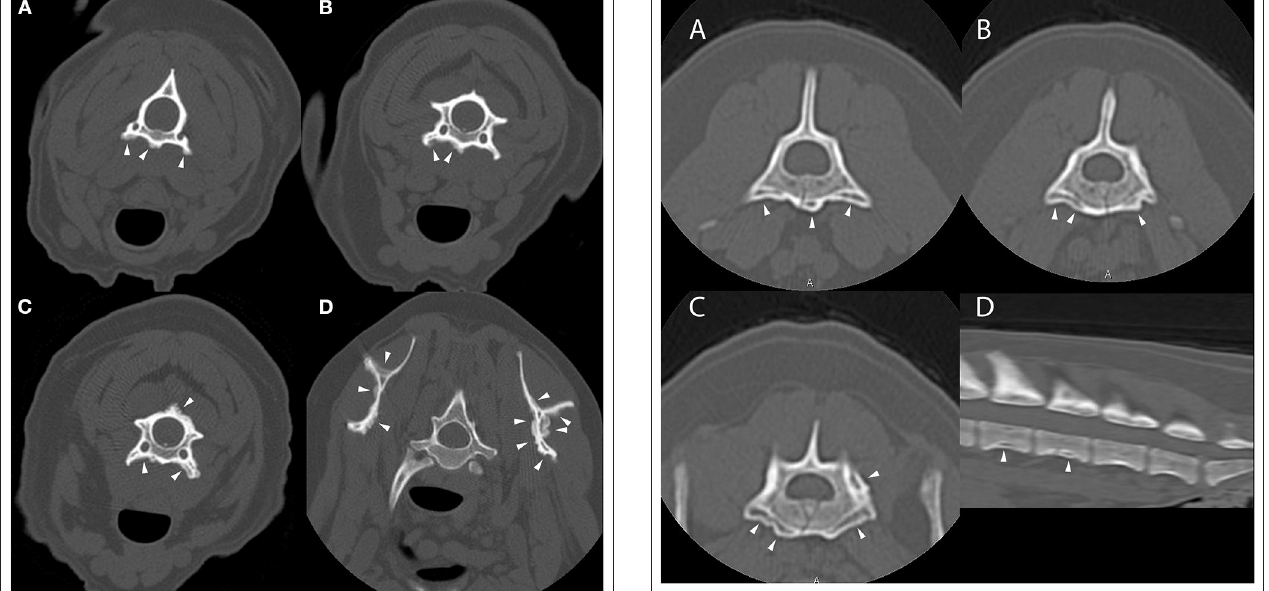
FIGURE 3 | Example of suspected lesions of American canine hepatozoonosis. Non-contrast transverse images of the second (A) , third (B) , and fourth cervical vertebrae (C) , as well as the first thoracic vertebra and scapulae (D) of a 6 year-old intact female miniature schnauzer dog in which a Hepatozoon americanum gamont was identified on a peripheral blood smear. In all images, there is multifocal, irregularly marginated periosteal proliferation on several non-articular surfaces of the vertebrae (white arrowheads). The underlying cortical margins are smooth, intact, and of normal thickness. In (A) , the ventral vertebral body and transverse processes bilaterally have similar lesions that do not connect. In (B) , the periosteal proliferation is lateralized to the right ventral vertebral body and transverse process. In (C) , similar lesions are also seen on the dorsal spinous process and lamina. In (D) , both medial and lateral surfaces of both scapulae are affected. This is an example of the marked asymmetry and irregularity of the periosteal proliferation.